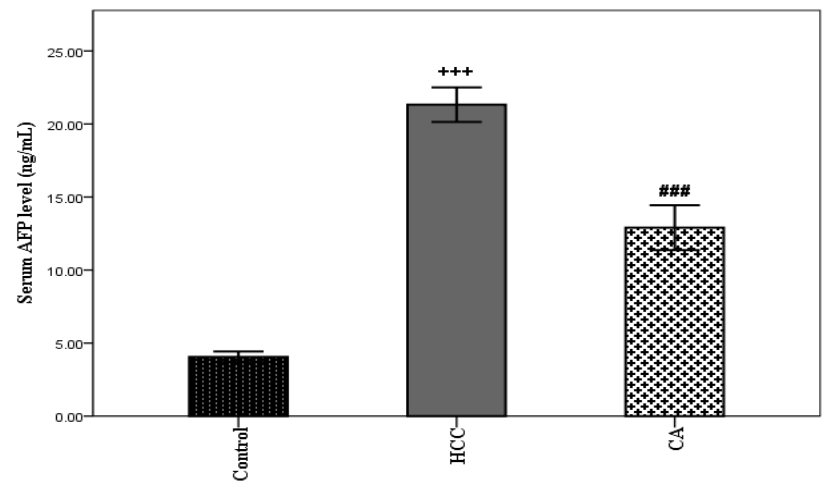
Figure 2. Effect of CA on serum AFP level. Data were expressed as mean ± S.E.M. Ten rats in each group. +++ p < 0.001 vs. control group, ### p < 0.001 vs. HCC group.